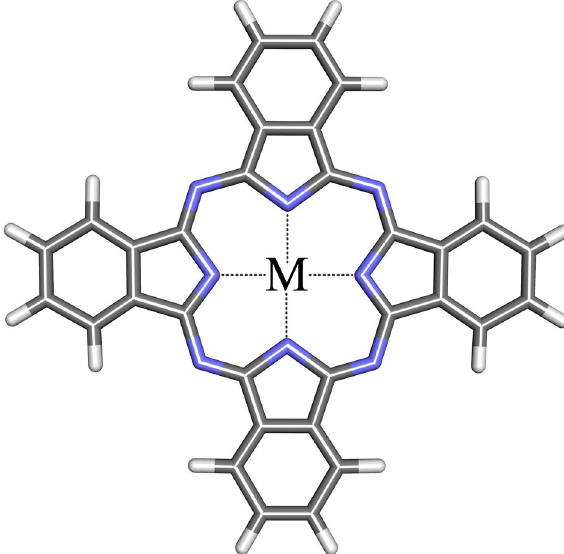
Figure 1. Phthalocyanine structure, M = Co, Cu e